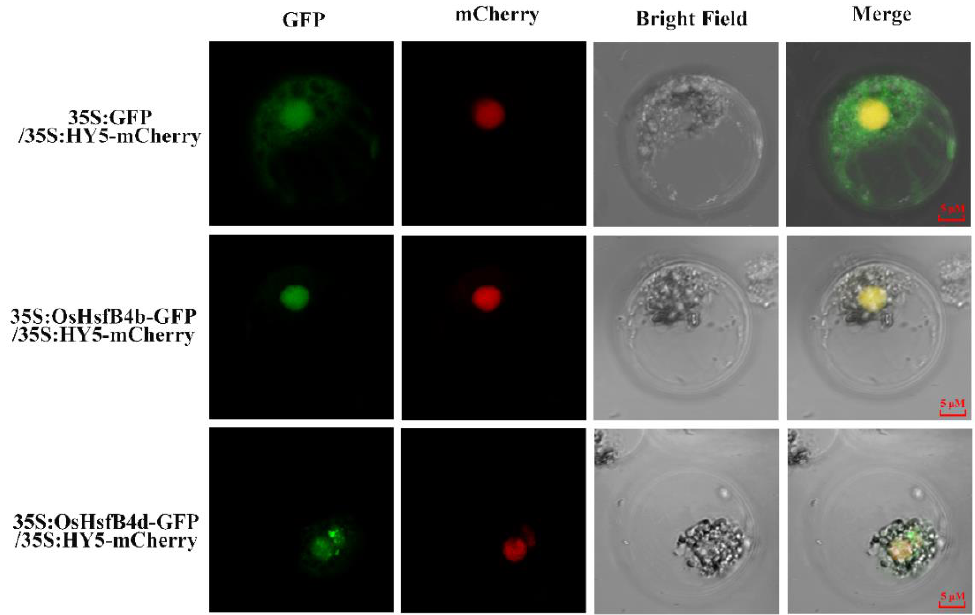
Figure 6. Subcellular localization of OsHsfB4b and OsHsfB4d proteins in rice protoplast. OsHsfB4b- GFP and OsHsfB4d-GFP fusion protein driven by the 35S promoter were transformed into the rice protoplast. GFP and mCherry signals are represented by a green and red color, respectively. Scale bars = 5 μM.